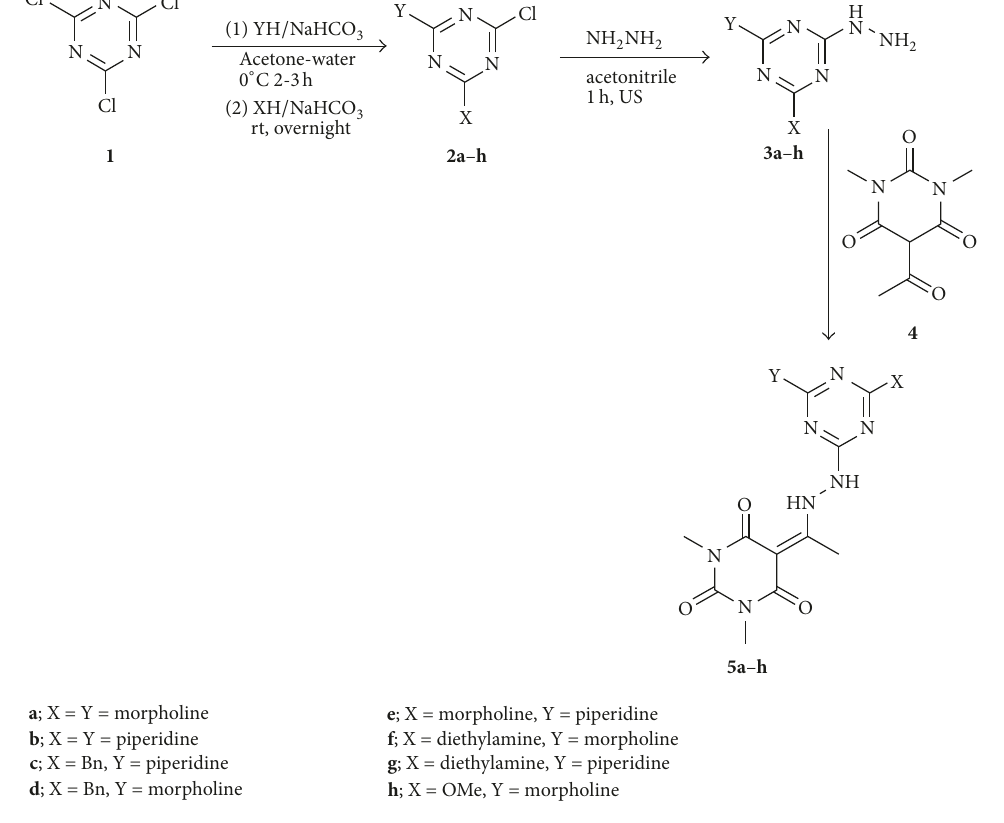
Scheme 1: Synthesis of pyrimidinetrione-s-triazine